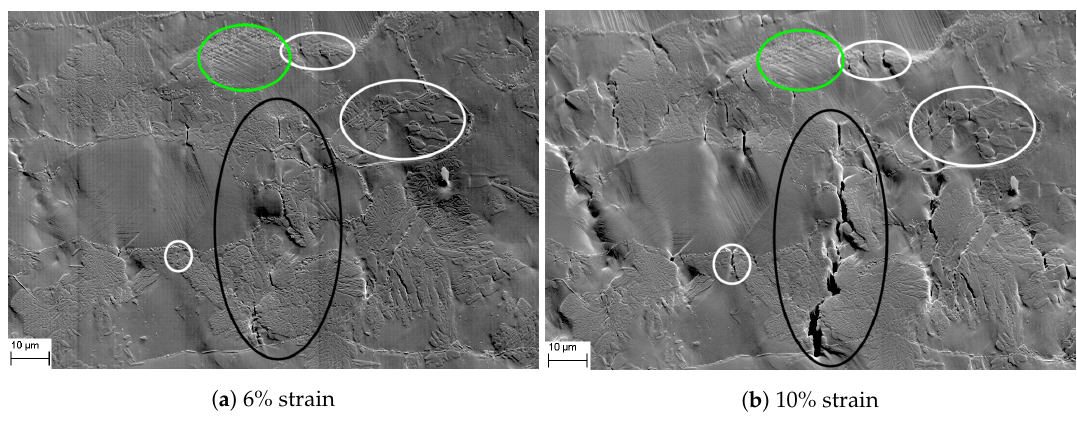
Figure 8. Micrographs of cracks formed in the σ -phase, taken from the test carried out at room temperature with 10% σ -phase present. Some cracks are restricted by the matrix while some propagate and coalesce. In the green circle, a heavily deformed austenite grain with cross-slip is seen. The white circles show microcracks restrained by the matrix and the large crack in the black circle was formed when many smaller cracks coalesce. A close-up of this crack is shown in Figure 9.